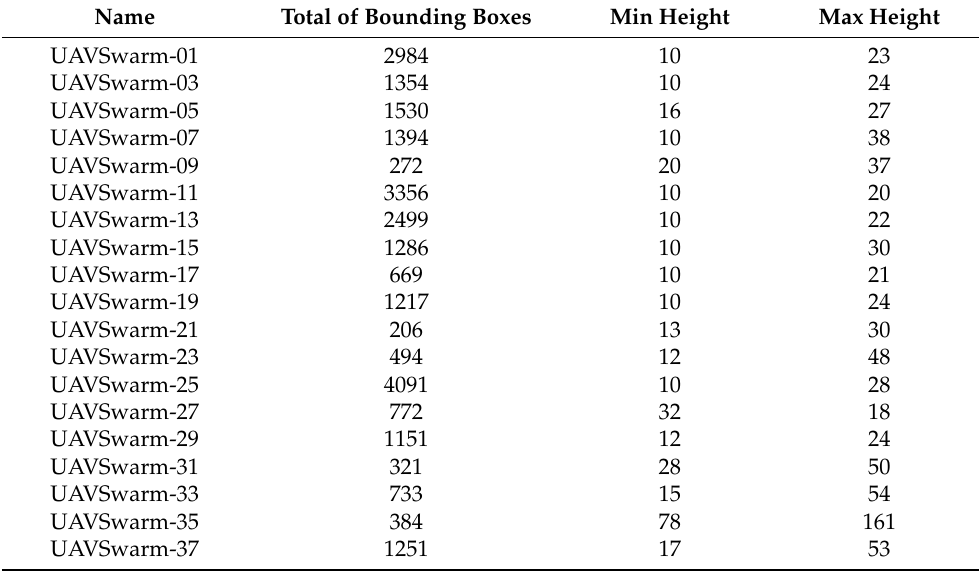
Table 3. The bounding box information of the training sequence in the UAVSwarm dataset.